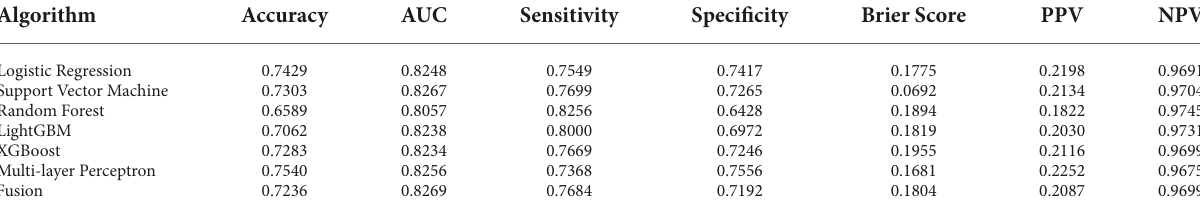
TABLE 3 Performance of machine learning models in the test set with features selected by logistics regression. Algorithm